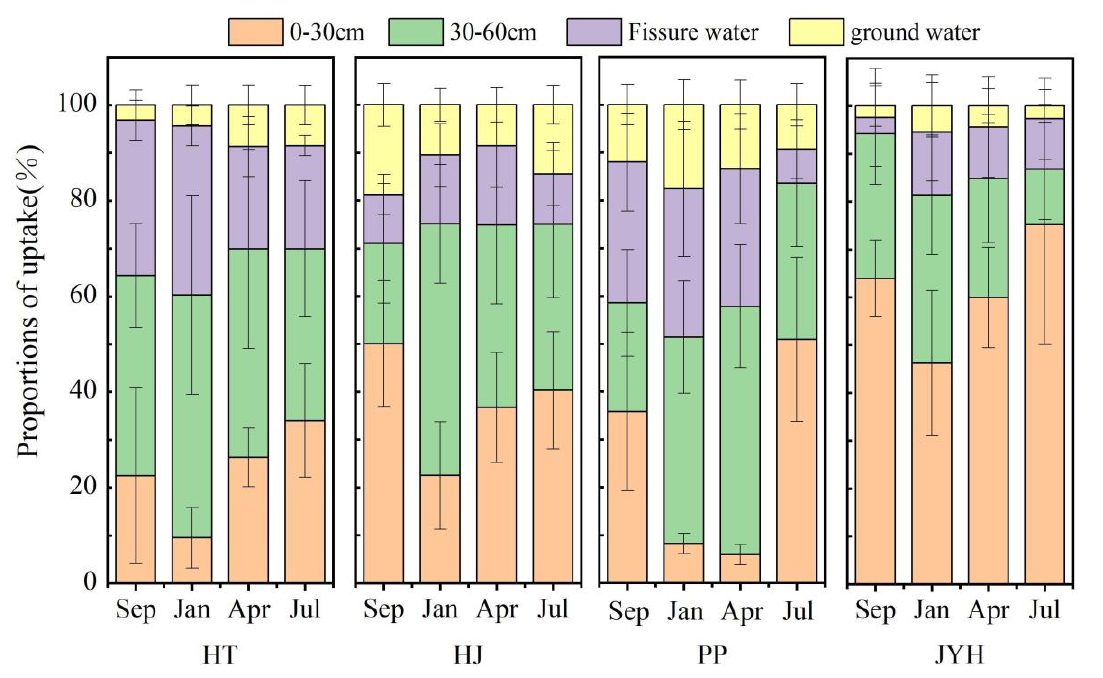
Figure 8. Seasonal variations in proportion of water uptake from different soil layers based on MixSIAR for HT, HJ, PP, and JYH. Error bars represent standard deviation. Table 2. Changes in water use ratio of four species in dry rainy